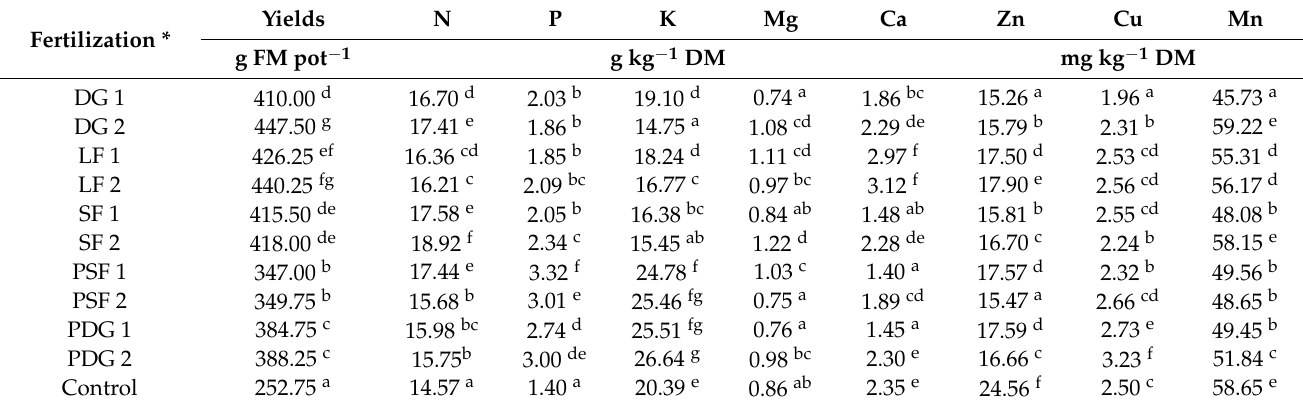
Table 5. Yields and chemical composition of maize. Fertilization *